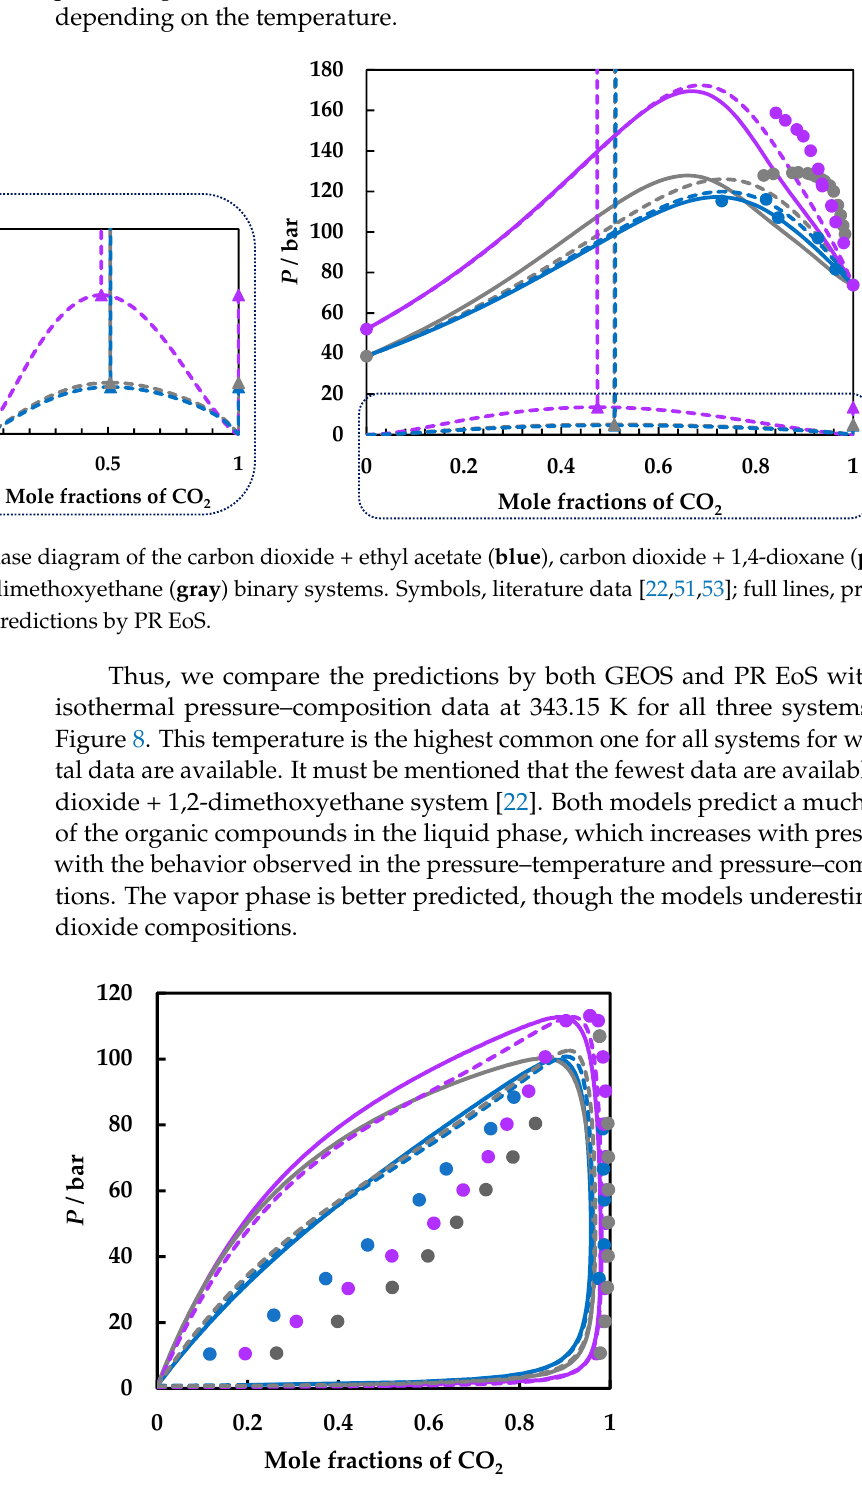
Figure 8. Comparison of literature data for CO 2 + ethyl acetate (blue) [54], + 1,4-dioxane (purple) [53], and + 1,2-dimethoxyethane ( gray ) [22] binary systems at T = 343.15 K and predictions by GEOS ( full lines ) and PR EoS ( dashed lines ).